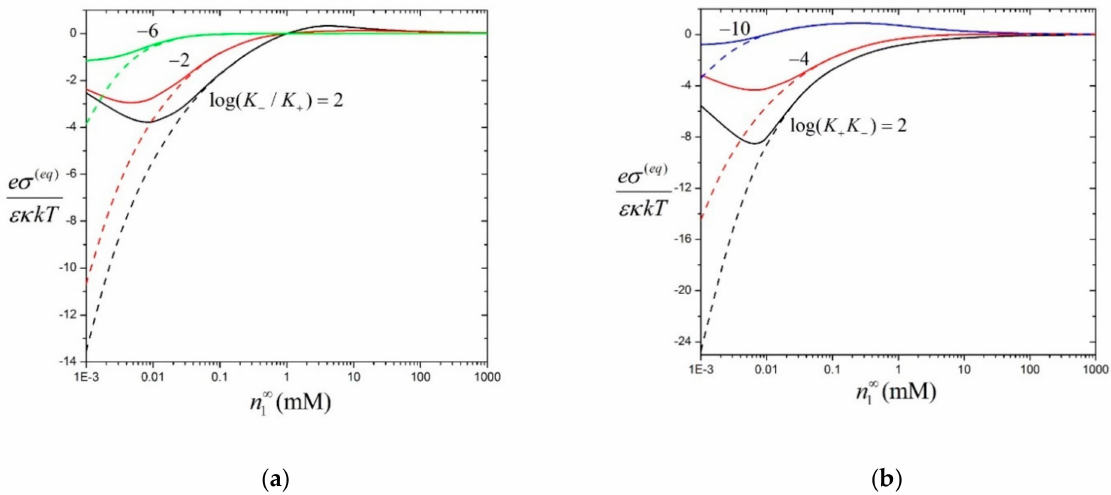
Figure 2. The dimensionless equilibrium surface charge density e σ ( eq ) / εκ kT versus the bulk concentration n ∞ aqueous 1-1 electrolyte solution in a fibrous medium with a = 100 nm and N = 1 × 10 16 site/m 2 : ( a ) K + K − = 10 − 6 M 2 ; ( b ) K − / K + = 10 − 2 . The solid and dashed curves represent the cases ϕ = 0.3 and ϕ = 0, respectively.